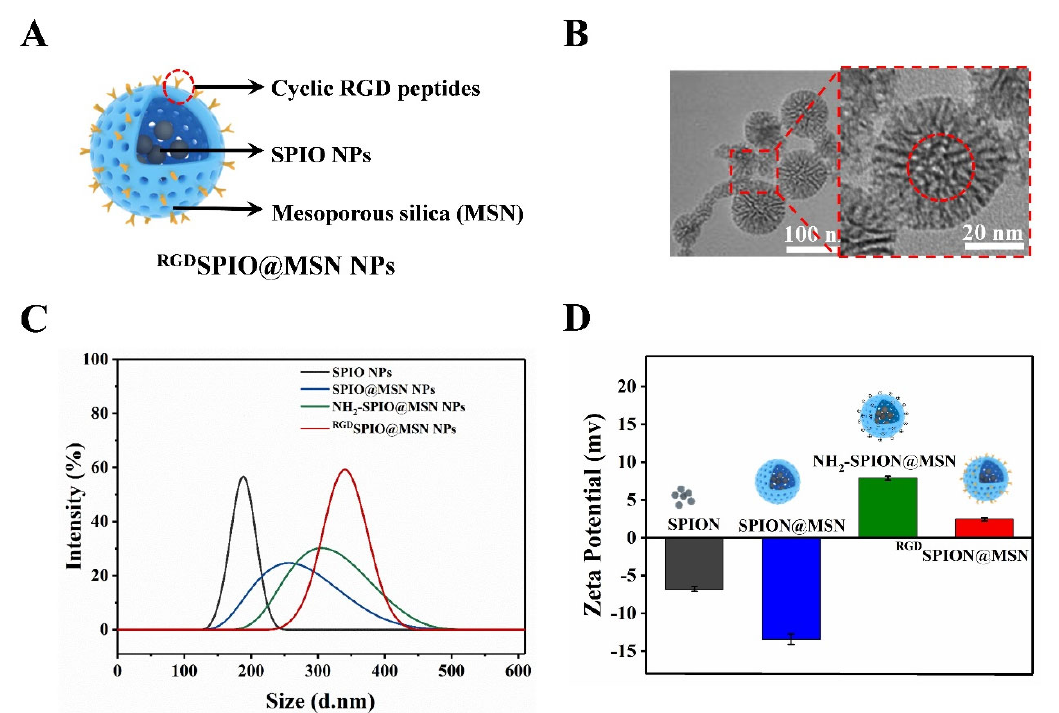
Figure 1. Characterization of various nanoparticles. ( A ) Schematic of RGD SPIO@MSN NPs composites, ( B ) TEM images of SPIO@MSN NPs, ( C ) hydrated particle sizes, and ( D ) zeta potentials of SPIO NPs, SPIO@MSN NPs, NH 2 -SPIO@MSN NPs, and RGD SPIO@MSN NPs.